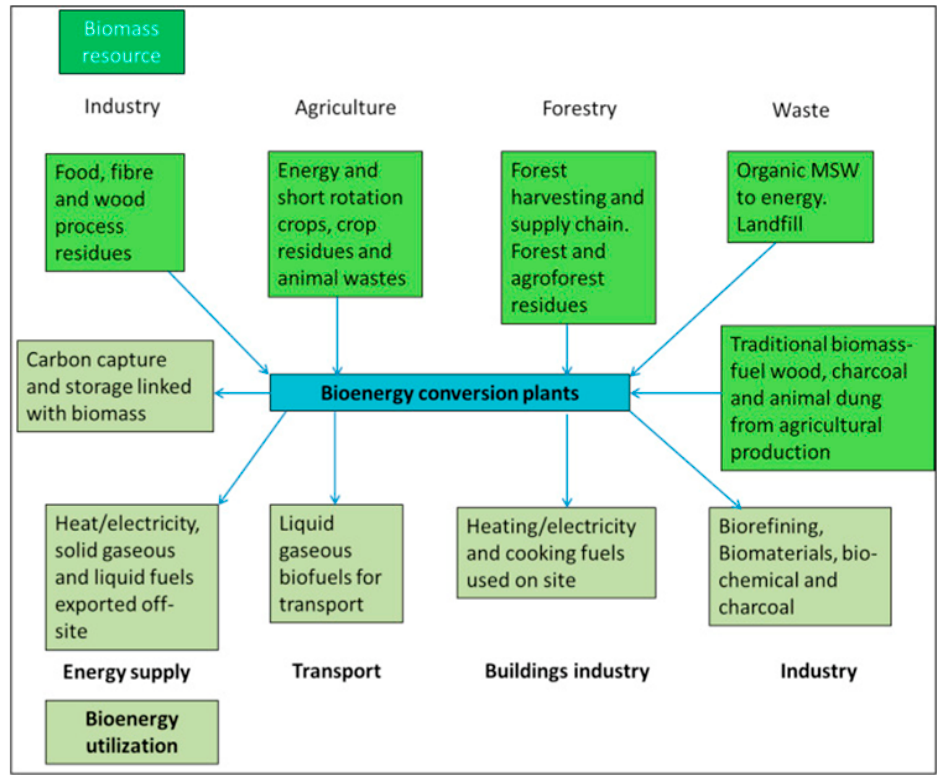
Figure 8. Overview of biomass resources and common products. Reprinted with permission from [65].